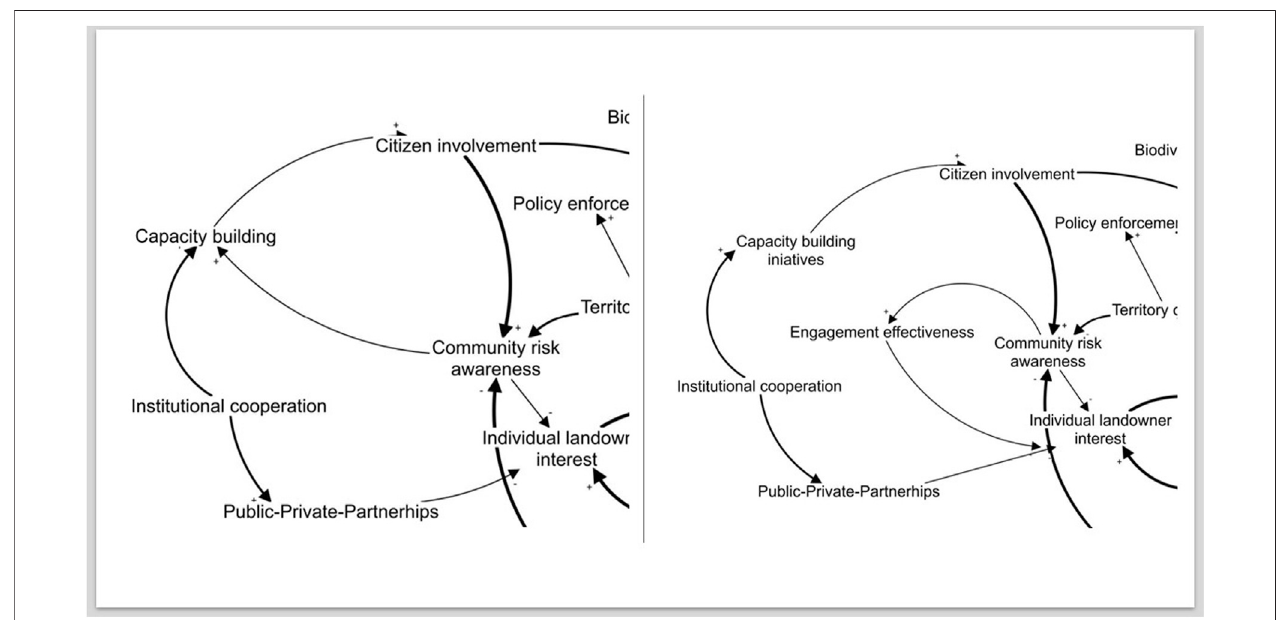
FIGURE 5 | (A) Structure of the map before the de-aggregation of circular relationships and (B) structure of the map after the de-aggregation of circular relationships.